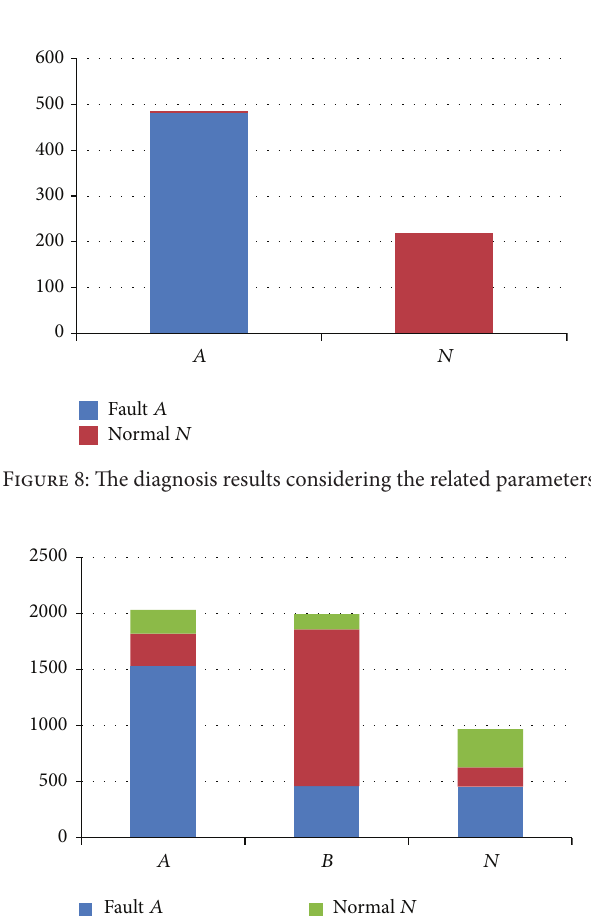
is the number of true faults. The experimental results are as shown in Figure 7.